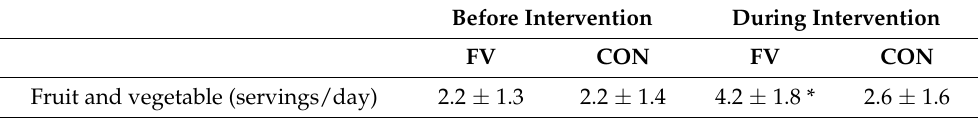
Table 2. Average number of servings per day of fruit and vegetables in both groups before and during the intervention. Before Intervention During Intervention FV CON FV CON Fruit and vegetable (servings/day)